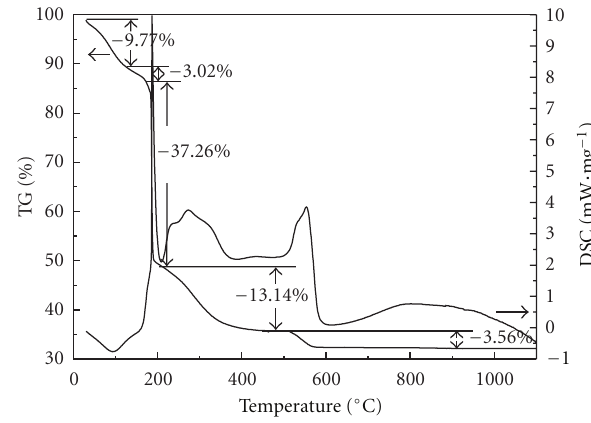
Figure 7: TG-DSC curves of TiO 2 sample.